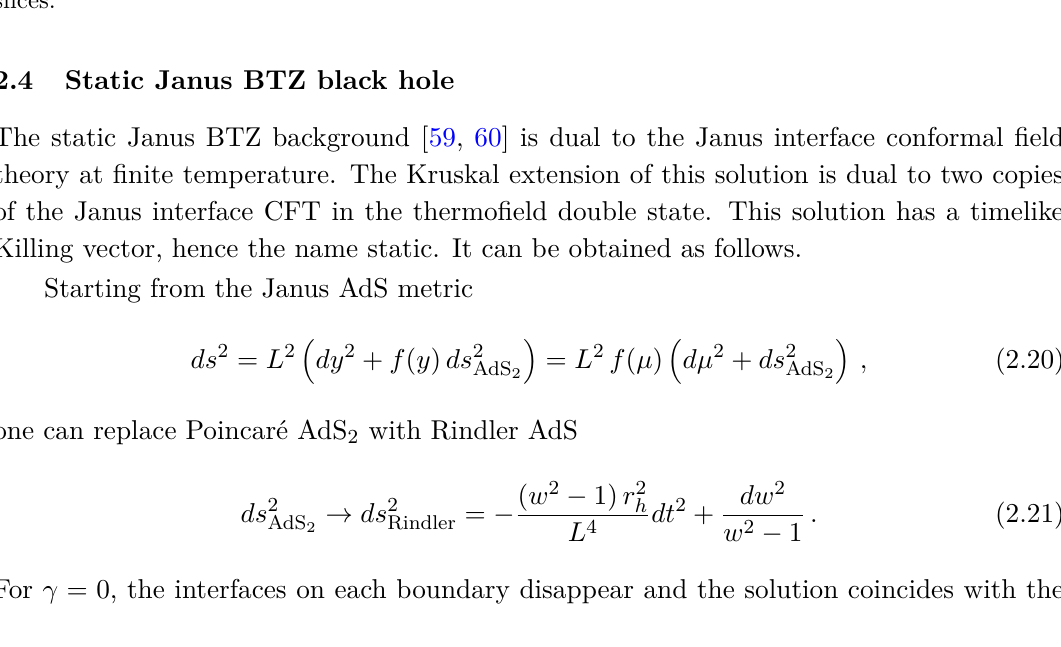
Figure 3 . Conformal diagram for the Janus AdS 3 geometry with global coordinates on the AdS 2